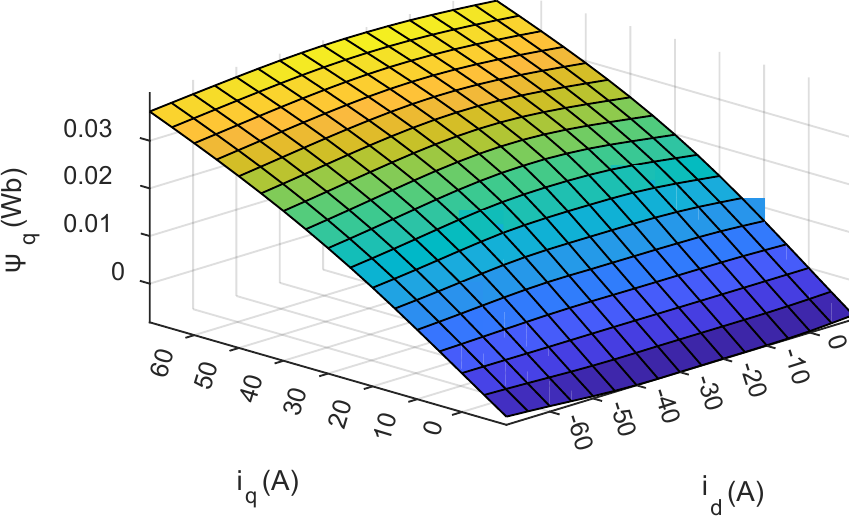
Figure 2. Measurement result of quadrature axis flux linkage. With the development of digital control, DSP and insulated gate bipolar transistor (IGBT) have been widely used in the machine control area. The current is sampled, trans- formed, and input into the current loop to calculate the voltage command value. Then, the converter outputs the voltage after a short delay, which is relative to the sampling period. If the machine is working in high-speed mode, the delay of the sampling–updating– outputting procedure cannot be neglected. Compared to synchronous SSSU, synchronous DSDU can double the sampling frequency and halve the delay time without increasing